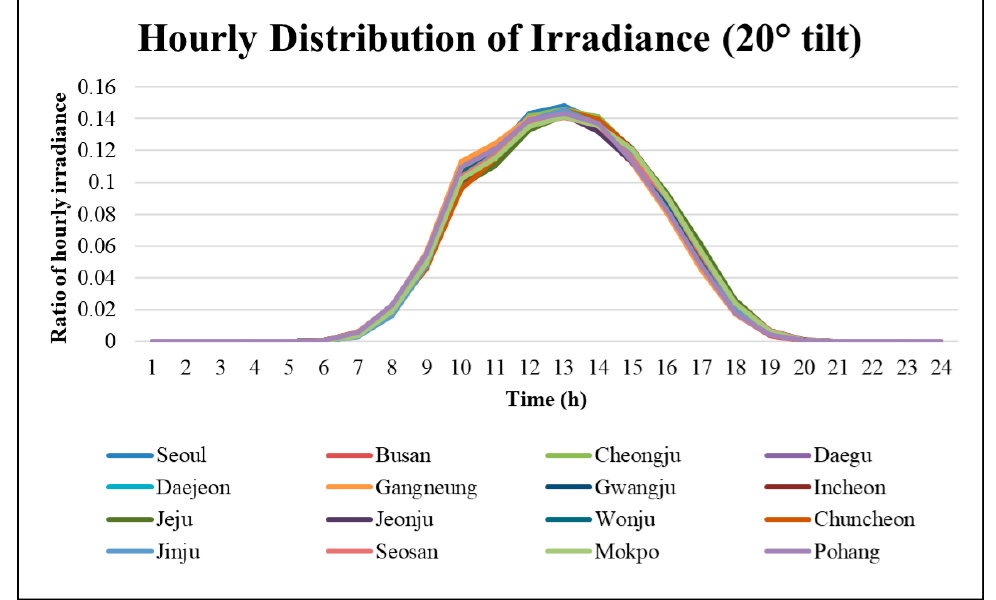
Figure 5. Graph of the ratio of hourly irradiance of each city in TMY dataset.